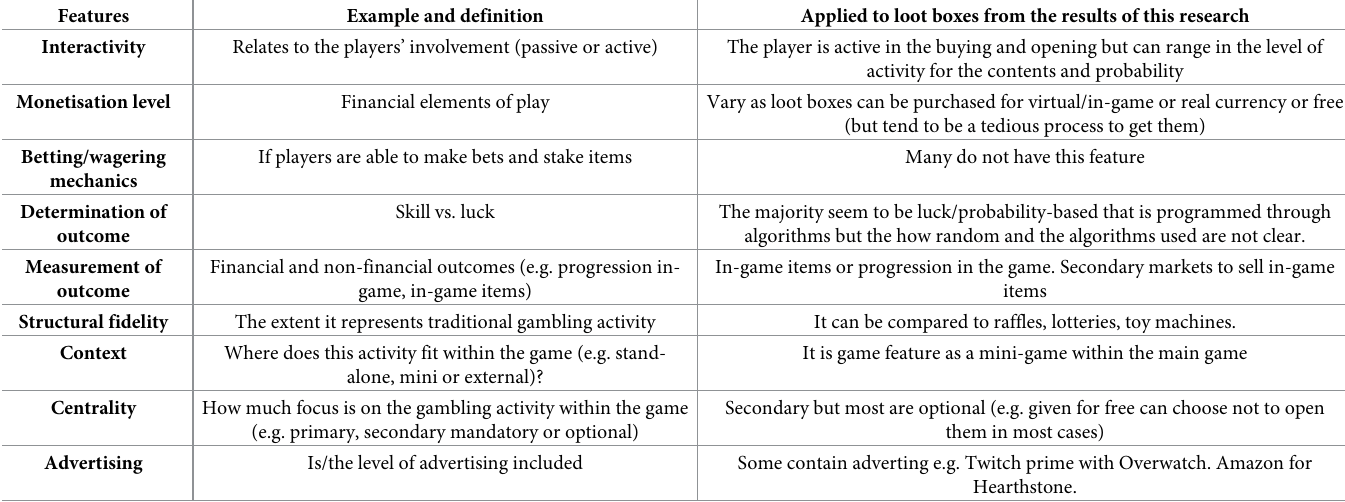
Table 2. The application of loot boxes and the results from this research to King et al. [43] description, definition, and examples of gambling features in games. Features